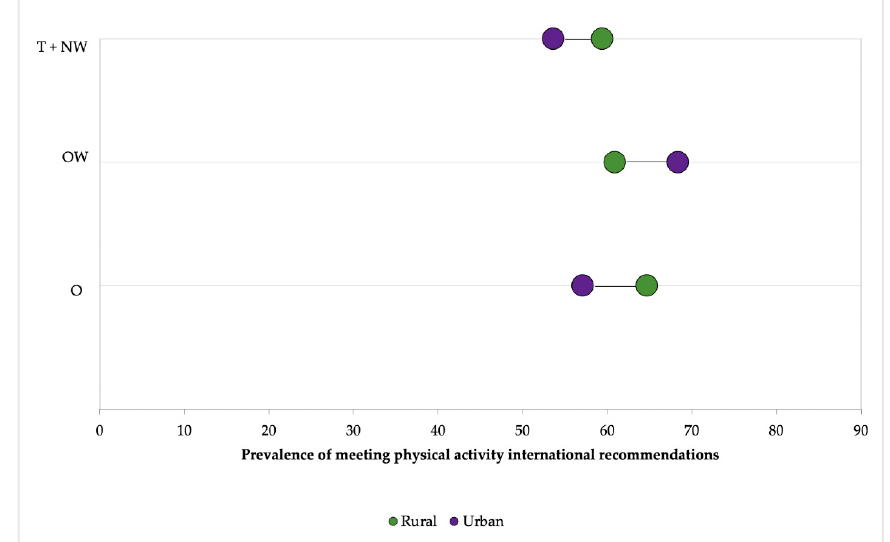
Figure 3. Prevalence of meeting physical activity international recommendations on PA for adolescents according to their BMI. T + NW = Thinness + Normal-weight; OW = Overweight; O = Obese.